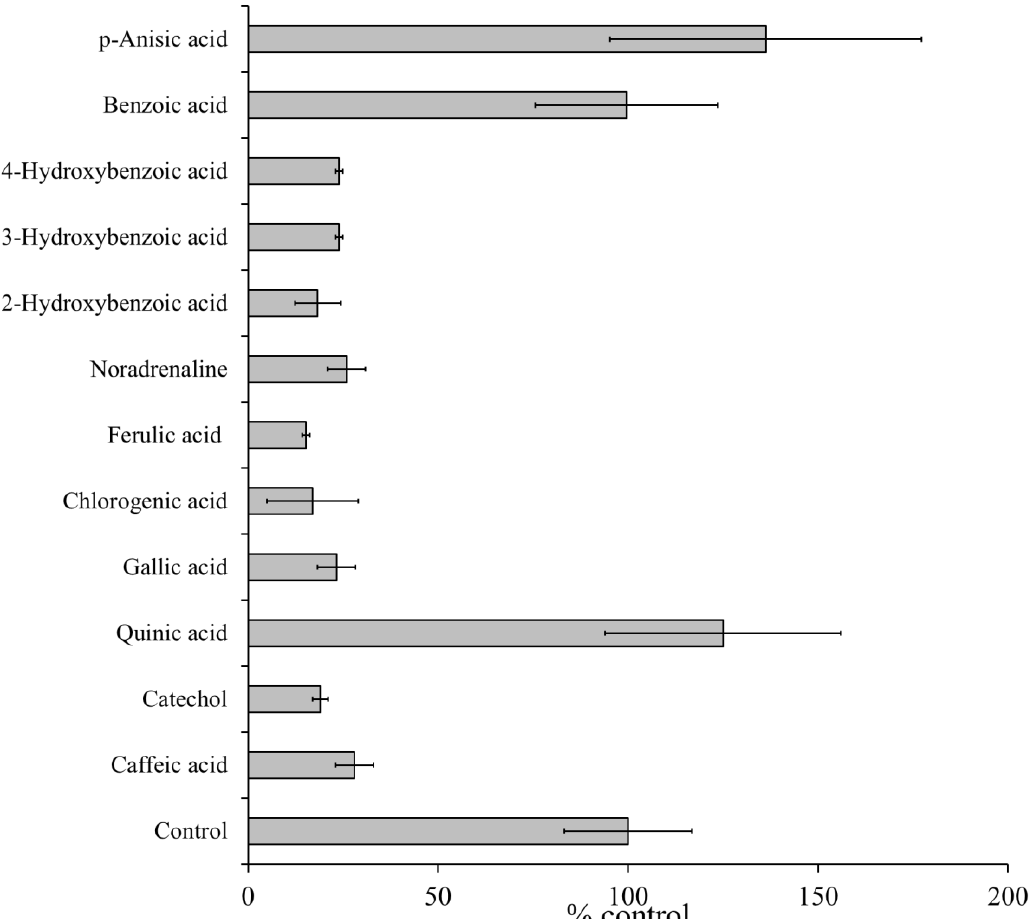
Figure 4. Effects of caffeic acid and related compounds on the formation of radicals